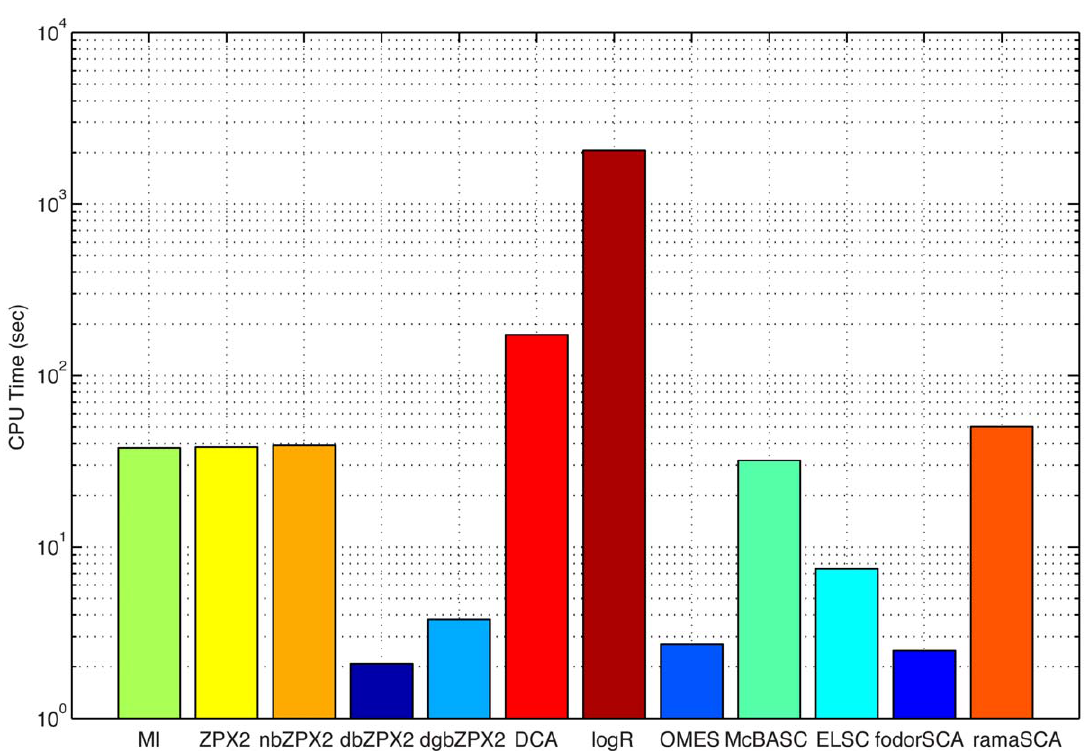
Figure 7. Execution (CPU) time of different coevolution detection methods for the experimental MSA of PHBH (183 seq. 6 394 aa.).